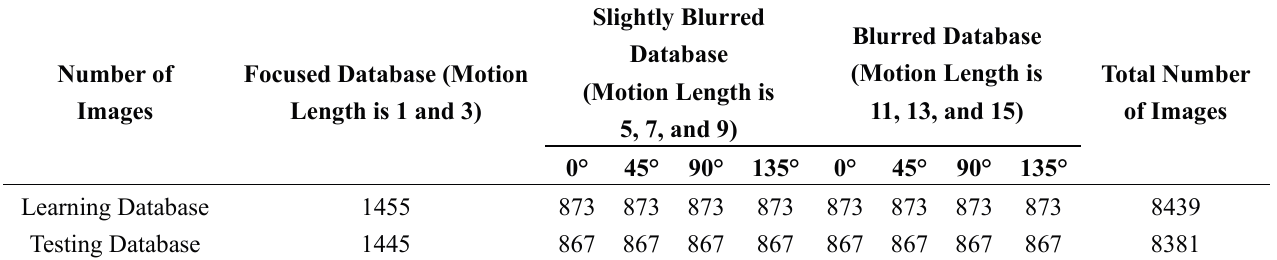
Table 3. Description of motion blur database used in our